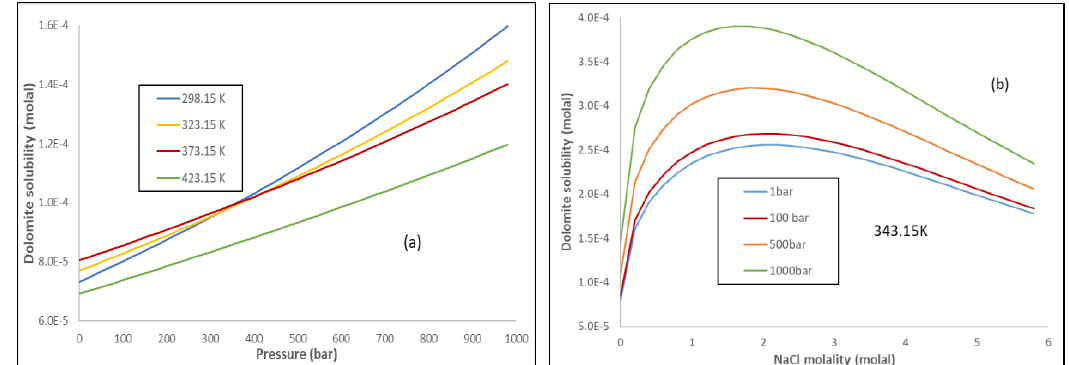
Figure 10. Dolomite solubility in pure water or NaCl solution calculated by this work at various temperatures, pressures and NaCl molalities. ( a ) Dolomite solubility varying with pressure at different pressures. ( b ) Dolomite solubility varying with NaCl molality at 343.15 (K) and various pressures.